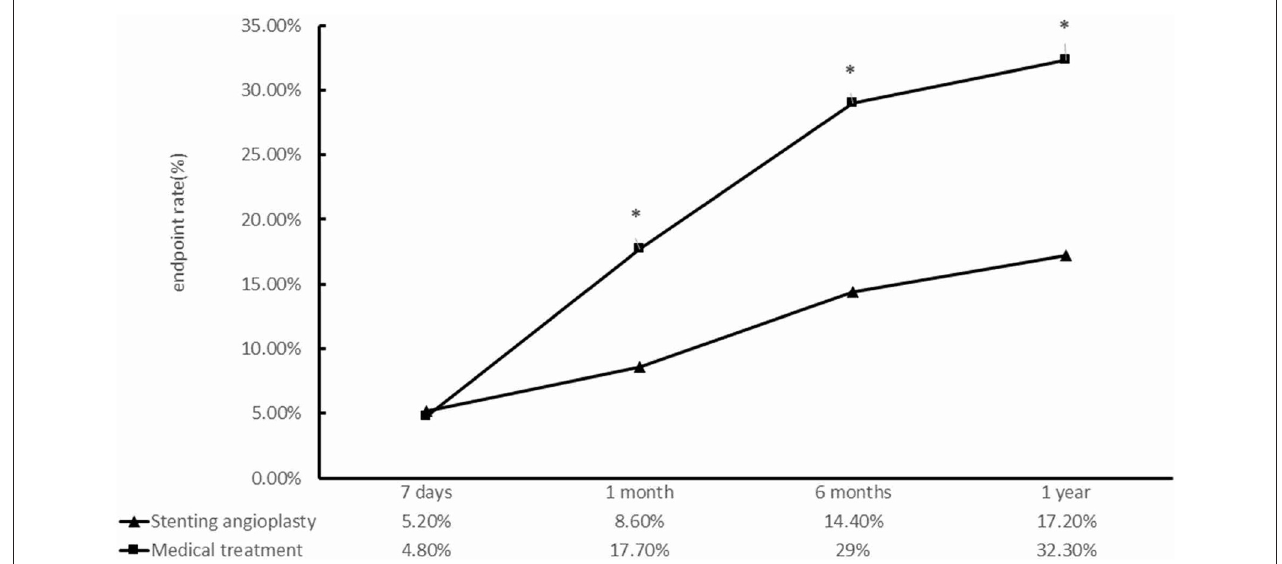
FIGURE 3 | Comparison between the standardized medical treatment group and the percutaneous transluminal angioplasty and stenting group for the primary endpoints at 7 days, 1, 6 months, and 1 year. * p < 0.05.